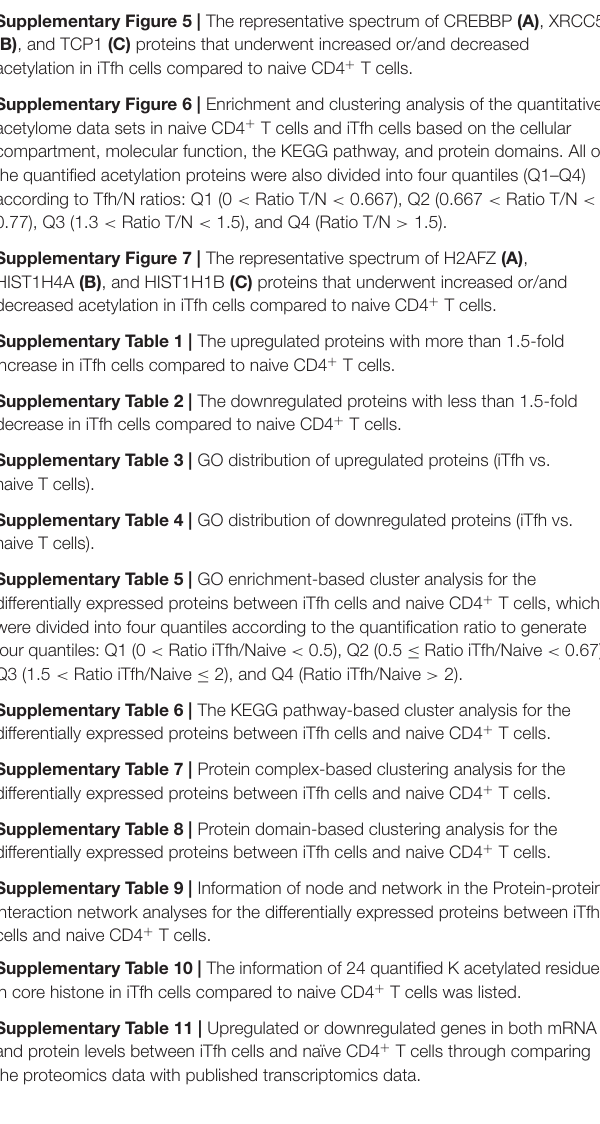
Supplementary Figure 3 | Gene ontology (GO) enrichment-based cluster analysis. The differentially expressed proteins were classified by GO annotation-based cellular compartment and molecular function. In each category, the quantified proteins in this study were divided into four quantiles according to